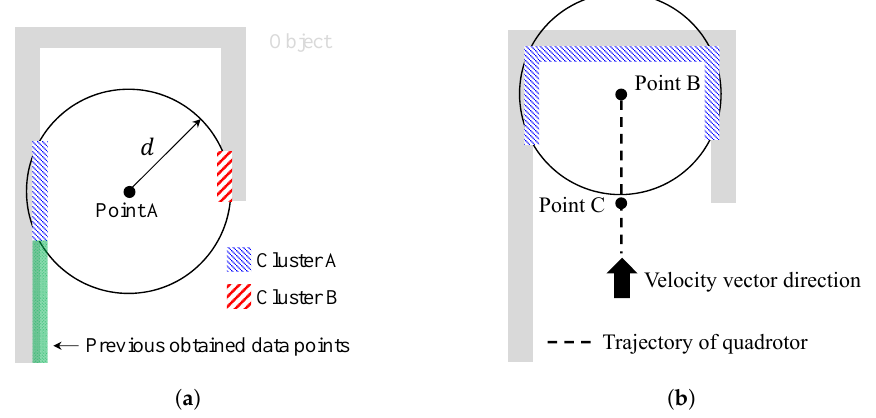
Figure 5. Narrow aisle example: ( a ) clustering; and ( b ) dead-end